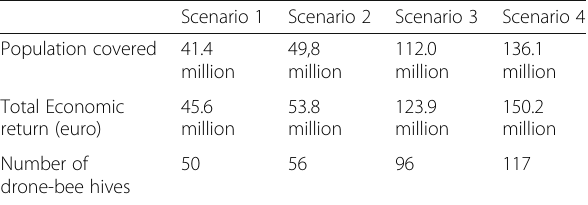
Table 1 Population covered, total economic return and number of viable hives (EU28) for an economic viability threshold of 650.000 euro